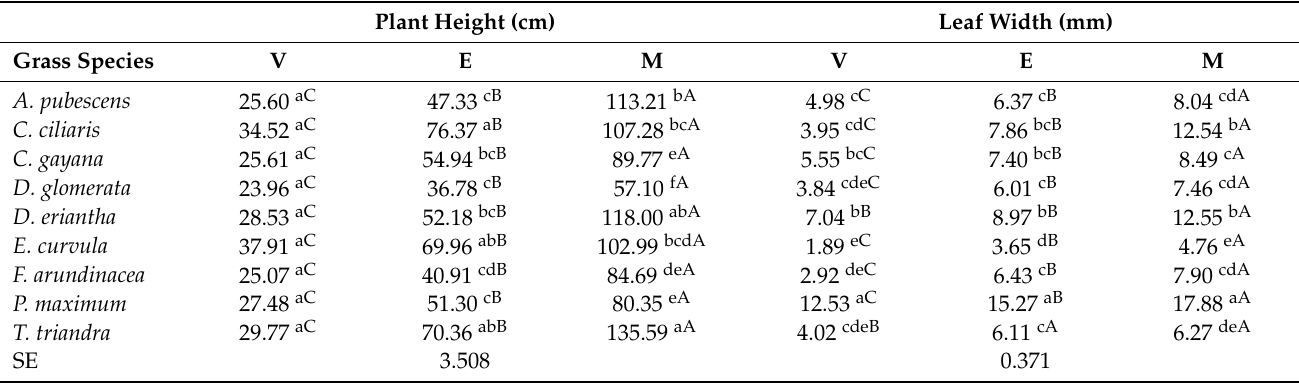
Table 1. Effect of grass species and growth stage on plant height (cm) and leaf width (mm) of nine selected grass species grown under controlled conditions.